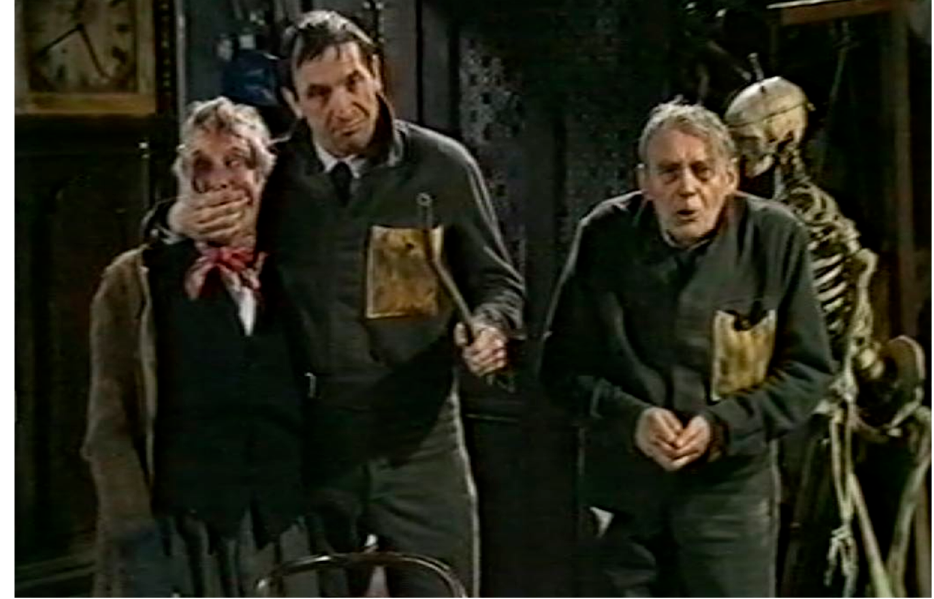
Figure 2. Johnny, with Frank (right), threatens the